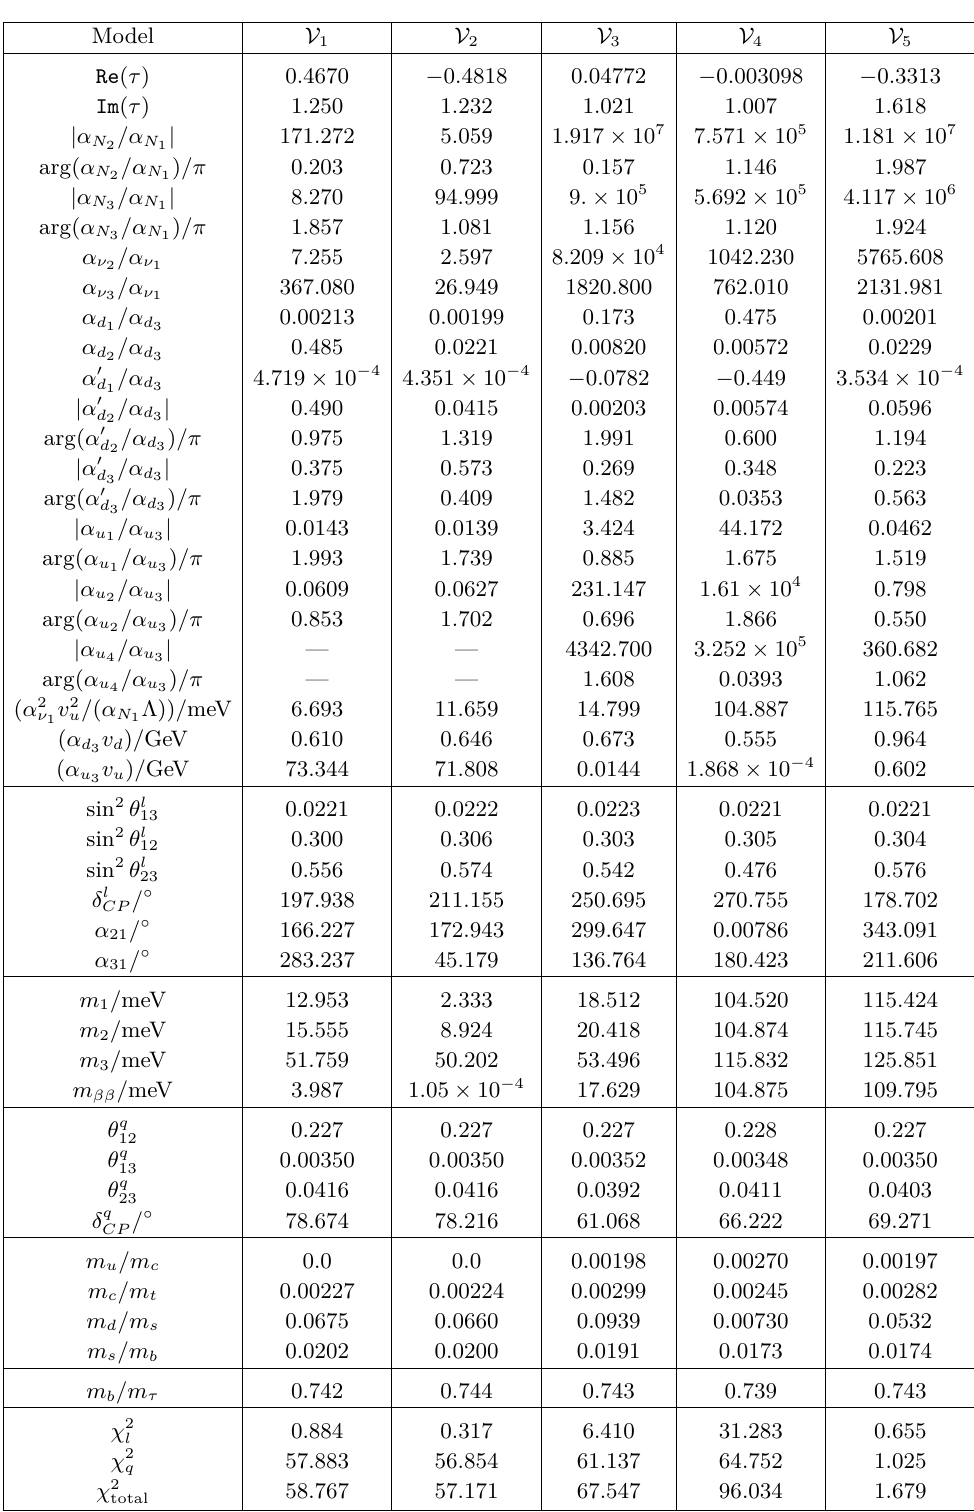
Table 9 . The best fit values of the free parameters and the corresponding predictions for lepton and quark mixing parameters and fermion masses for the phenomenologically viable models of